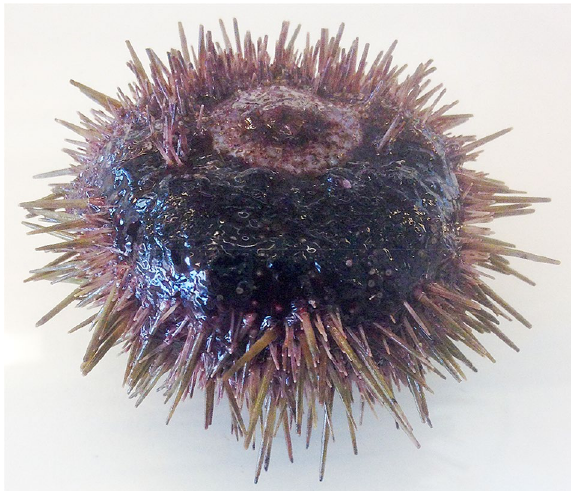
Figure 1. Lesion syndrome of green sea urchin ( S. droebachiensis ) reported in Northern Norway. The animal here is presented up-side down with mouth located on the top.